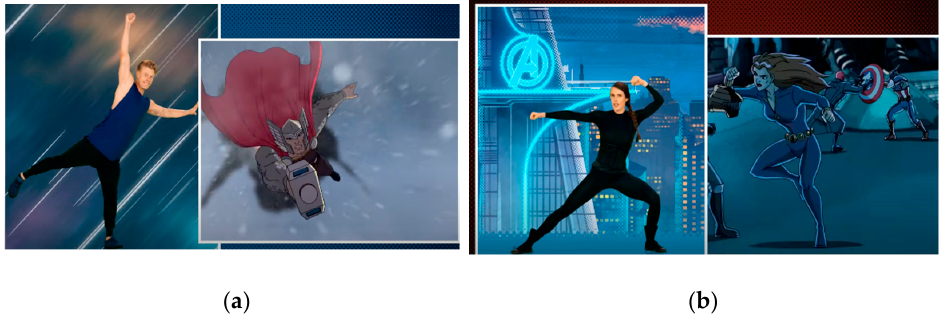
Figure 4. ( a ): Still from Video, Thor Flying, ( b ): Still from Video, Black Widow